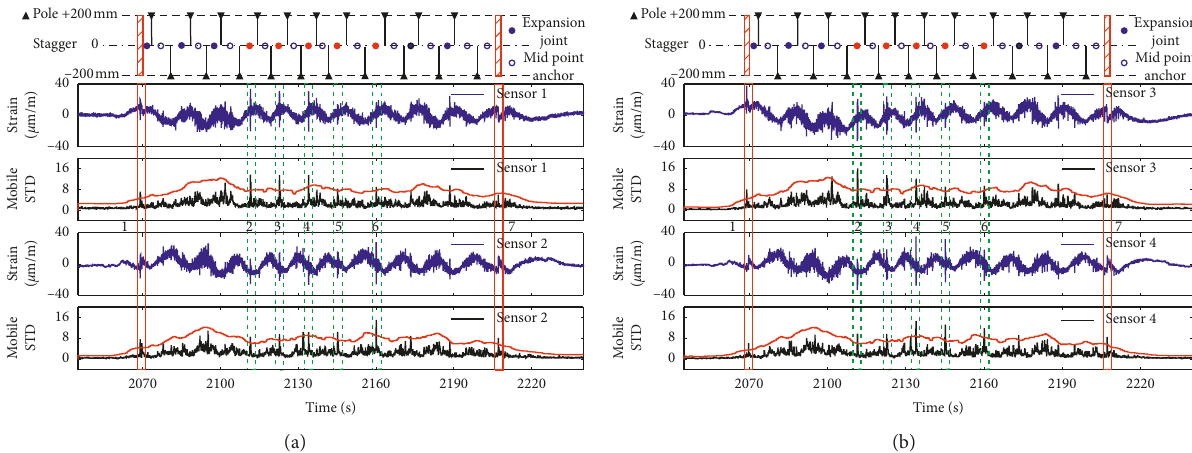
Figure 6: Processed strain signals and the mobile STD during regular operation (the time window Ts is 0.2s). (a) Front collector. (b) Rear